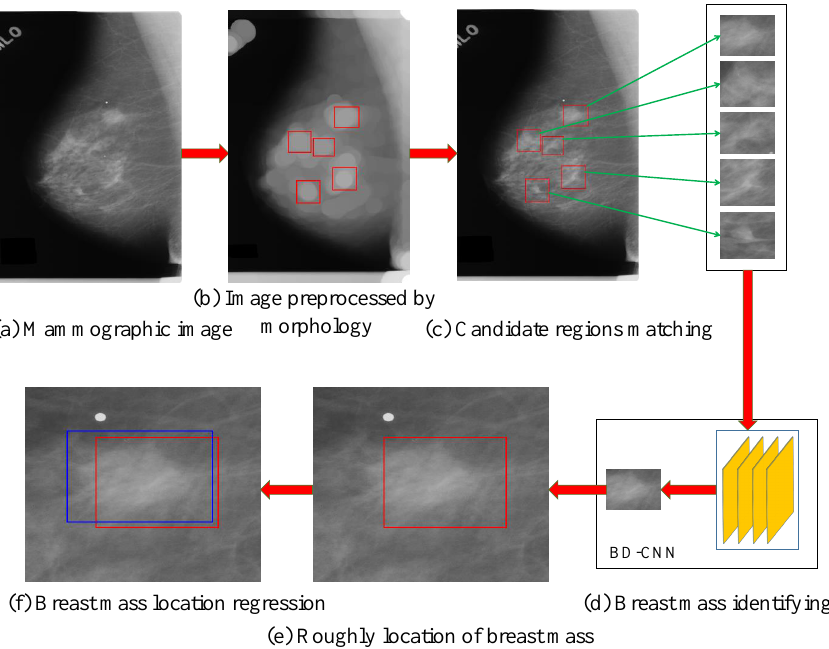
Figure 2. Flow chart of the breast mass detection method for the mammographic image. Where ( a ) is the mammographic image, ( b ) shows the matched regions on the processed mammographic image, ( c ) shows the suspected regions of breast mass generated using the mathematical morphology and image template matching methods on ( a ). ( d ) shows the process of breast mass identified using BD-CNN. The red rectangles in ( e , f ) are the regions of breast mass generated by the previous works. The blue rectangle in ( f ) is the refined bounding box of a breast mass using